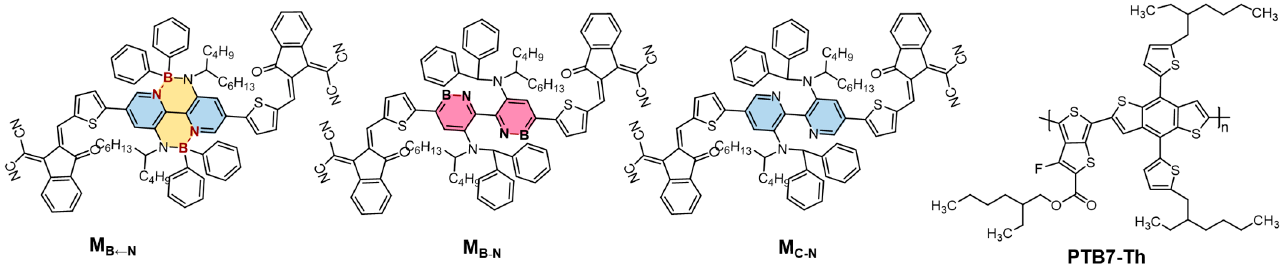
Figure 1. Molecular structures of the investigated acceptors and donor PTB7-Th.